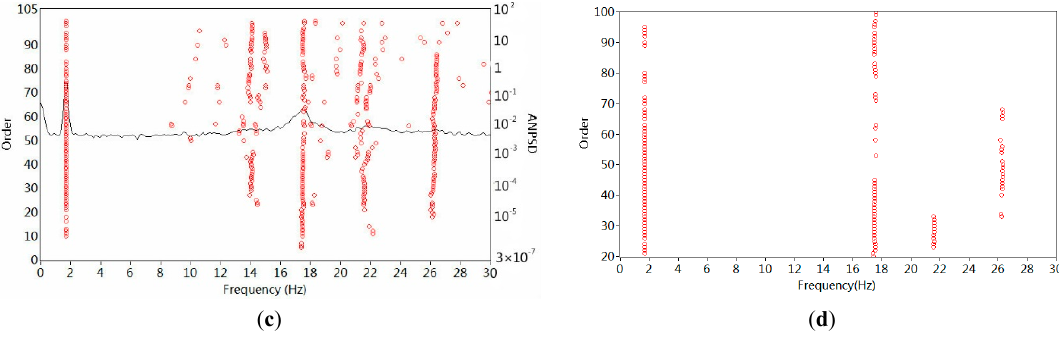
Figure 5. Identification of the physical modes of the wind turbine model. ( a ) Strain-based stabilization diagram; ( b ) cleaning stabilization diagram of (a); ( c ) acceleration-based stabilization diagram; ( d ) cleaning stabilization diagram of (c). Table 2. Identified modal parameters from the acceleration and strain responses.